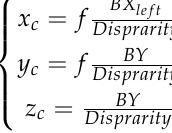
In binocular vision detection, the 3D coordinates of point P ( x c , y c , z c ) are shown in Equation (13):